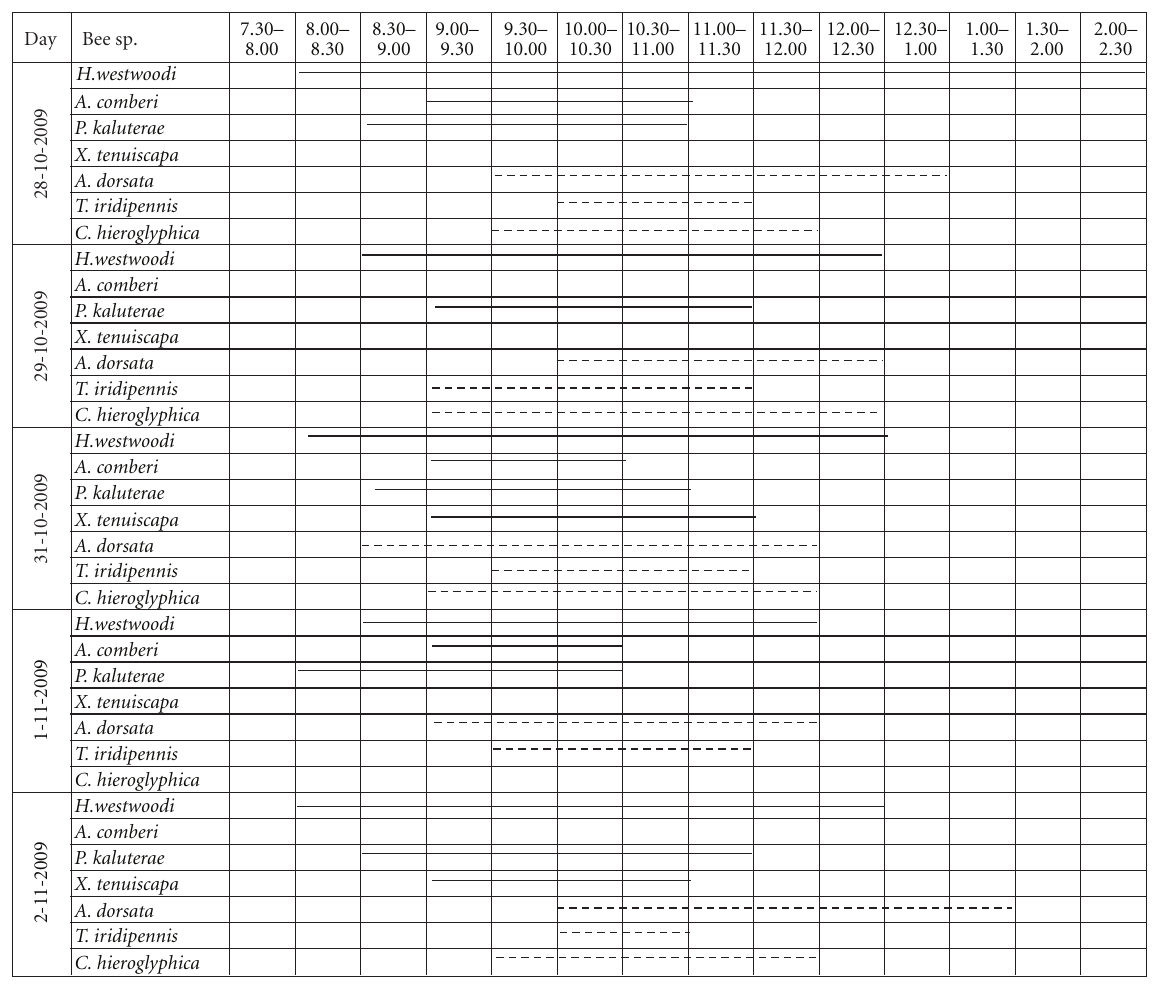
Figure 3: Activity time of seven species of bees ( Hoplonomia westwoodi , Amegilla comberi , Patellapis kaluterae , Xylocopa tenuiscapa , Apis dorsata , Trigona iridipennis , and Ceratina hieroglyphica ; — pollen bees, – – –honeybees) visiting flowers of Solanum violaceum from 7.30 a.m. to 2.30 p.m. during 5 sunny days in the site at